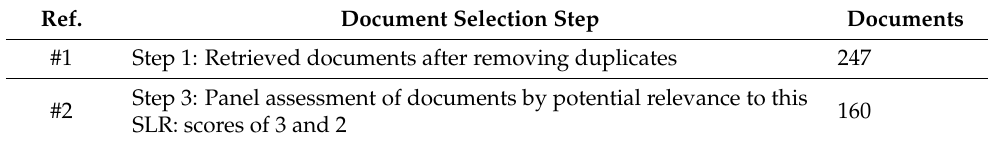
Table A3. Document selection for the systematic literature